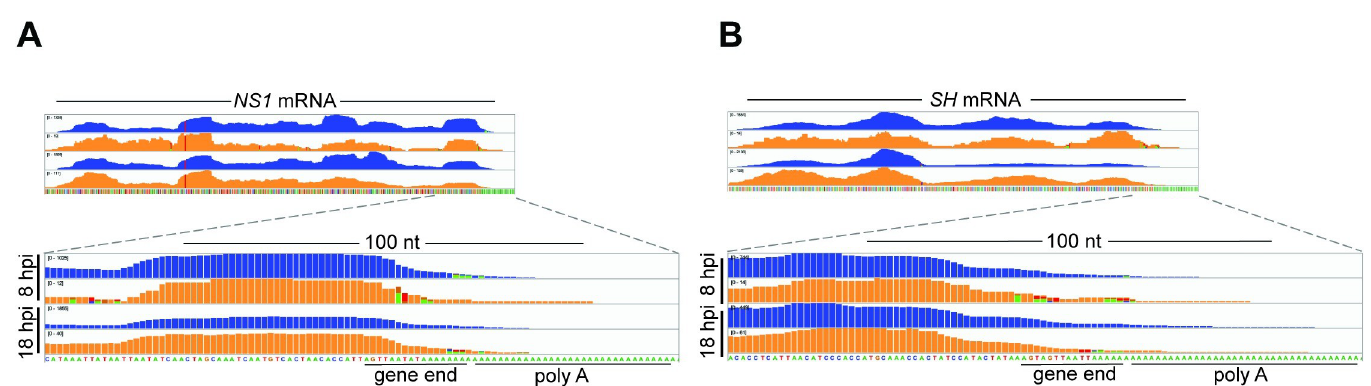
Fig 6. M2-1 does not bind with a higher density at RSV gene end sequences than at intragenic regions. Read coverage tracks of positive sense RSV reads aligned to RSV NS1 (A) and SH (B) mRNA sequences containing a 41 nt polyadenylate sequence added to the 3´ end. The tracks show IP (blue) and SMInput (orange) traces for the 8 and 18 hpi replicate 2 samples. The positions of the positive-sense gene end and polyadenylate sequences are indicated. Note that the sequence is written as positive sense DNA.